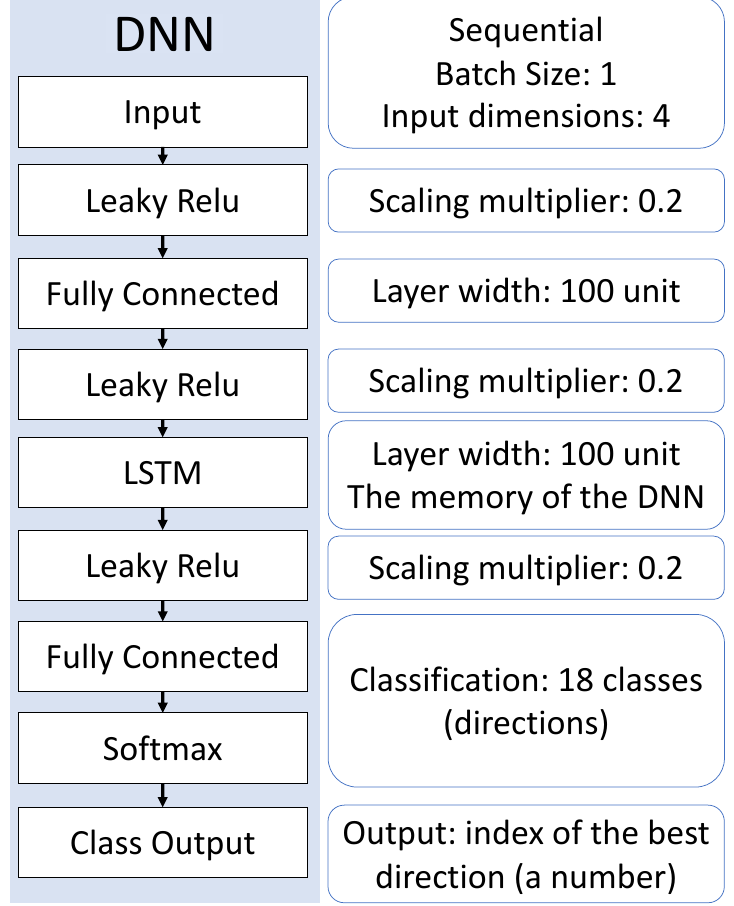
Figure 3. The used DNN